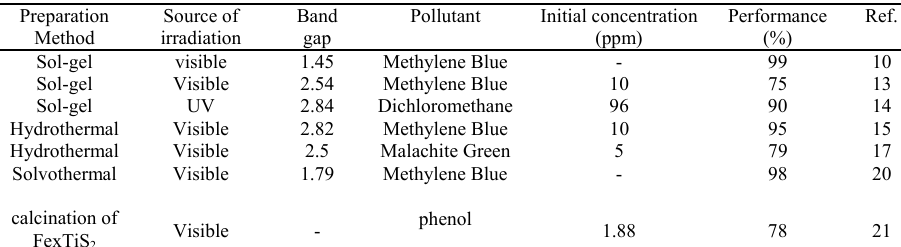
Table 1. Preparation method and characterization of some Fe-doped TiO 2 photocatalysts